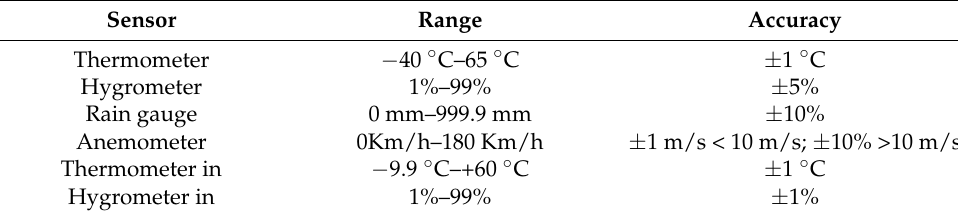
Figure 3. A schematic diagram of the meteorological monitoring system. Table 1. Technical specifications of the WS1060 weather